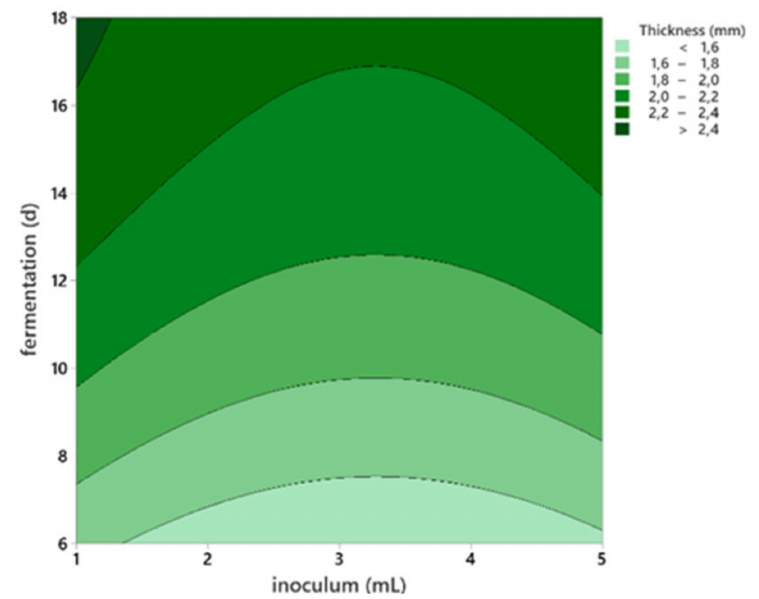
Figure 2. The response surface plot of thickness performed on the factorial design with 5